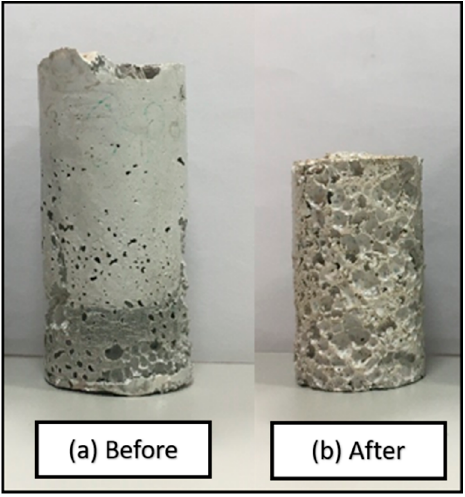
Figure 6. Samples ( a ) before machining, ( b ): being machined and shaped into uniform shape for easier calculations with a CNC turning machine.